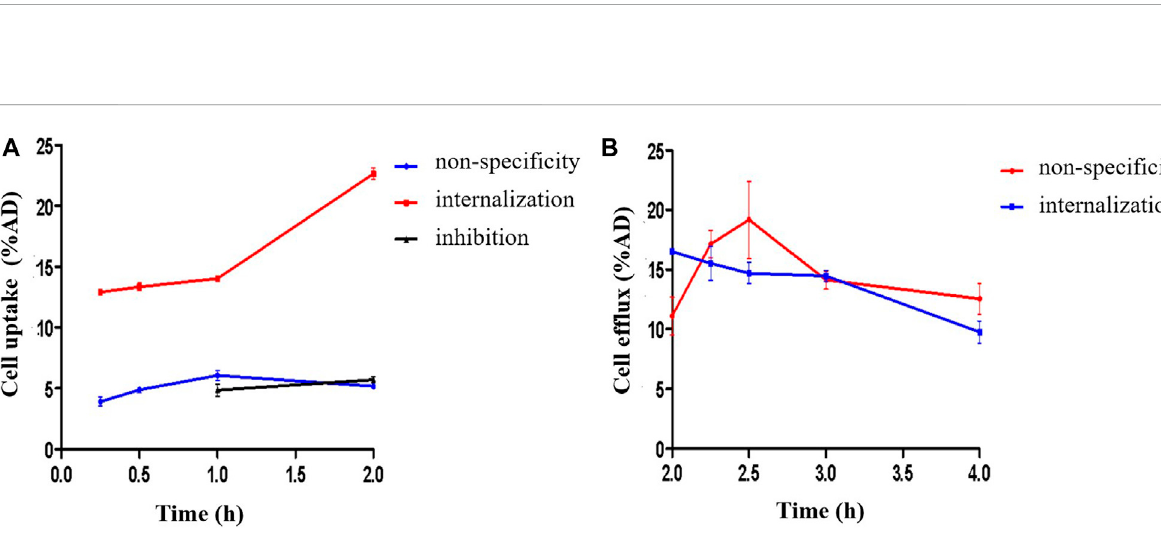
FIGURE 4 Uptake (A) , and ef fl ux assay (B) of 18 F-VUIIS1008 in RAW264.7